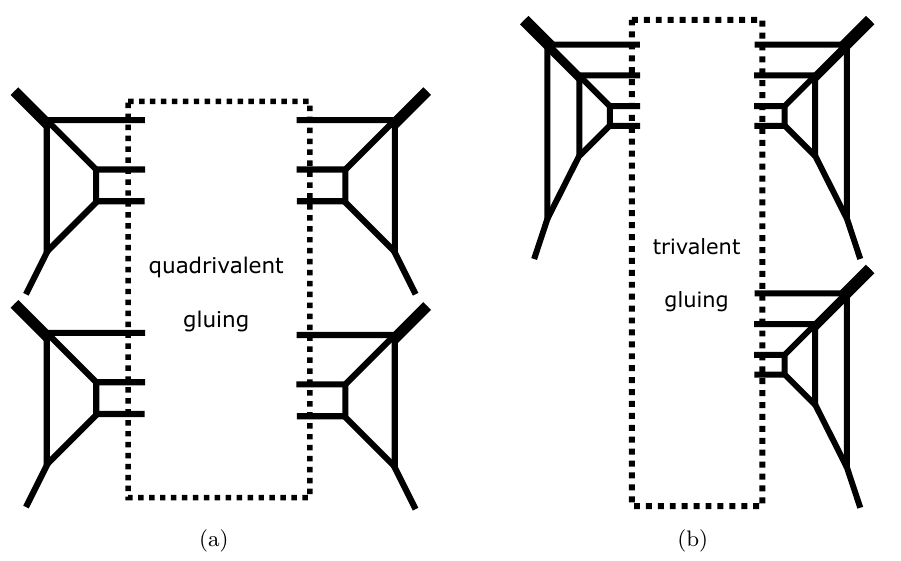
Figure 49. (a). The web diagram for the 5d SU(3) gauge theory with the CS level κ = 9 . (b). The web diagram for the 5d SU(4) gauge theory with the CS level κ = 8 .